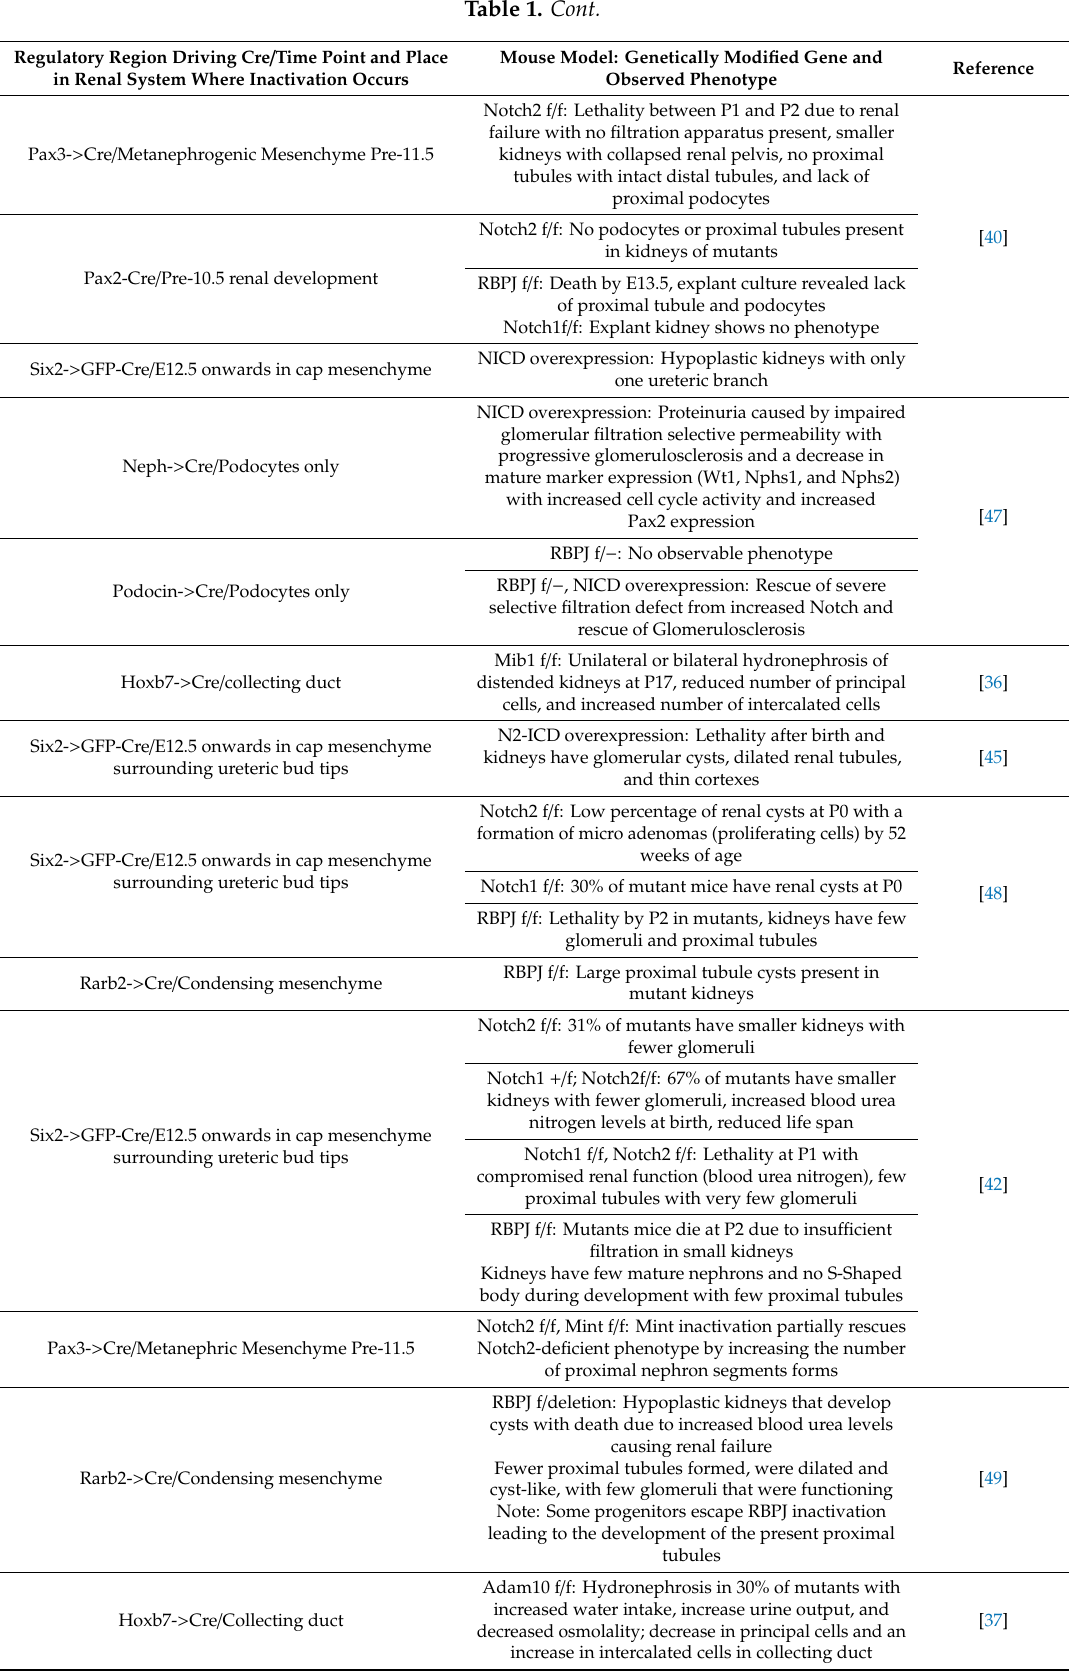
Mouse Model: Genetically Modified Gene and Observed Phenotype